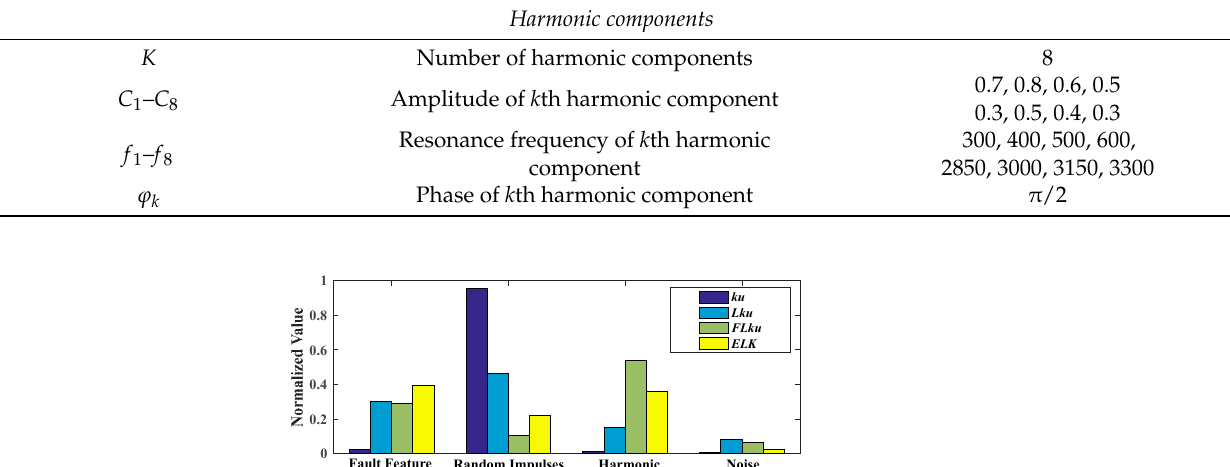
Figure 2. Comparison of the four indexes.